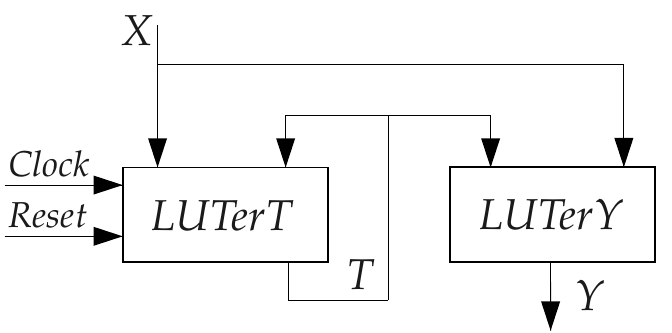
Figure 1. Structural diagram of P Mealy